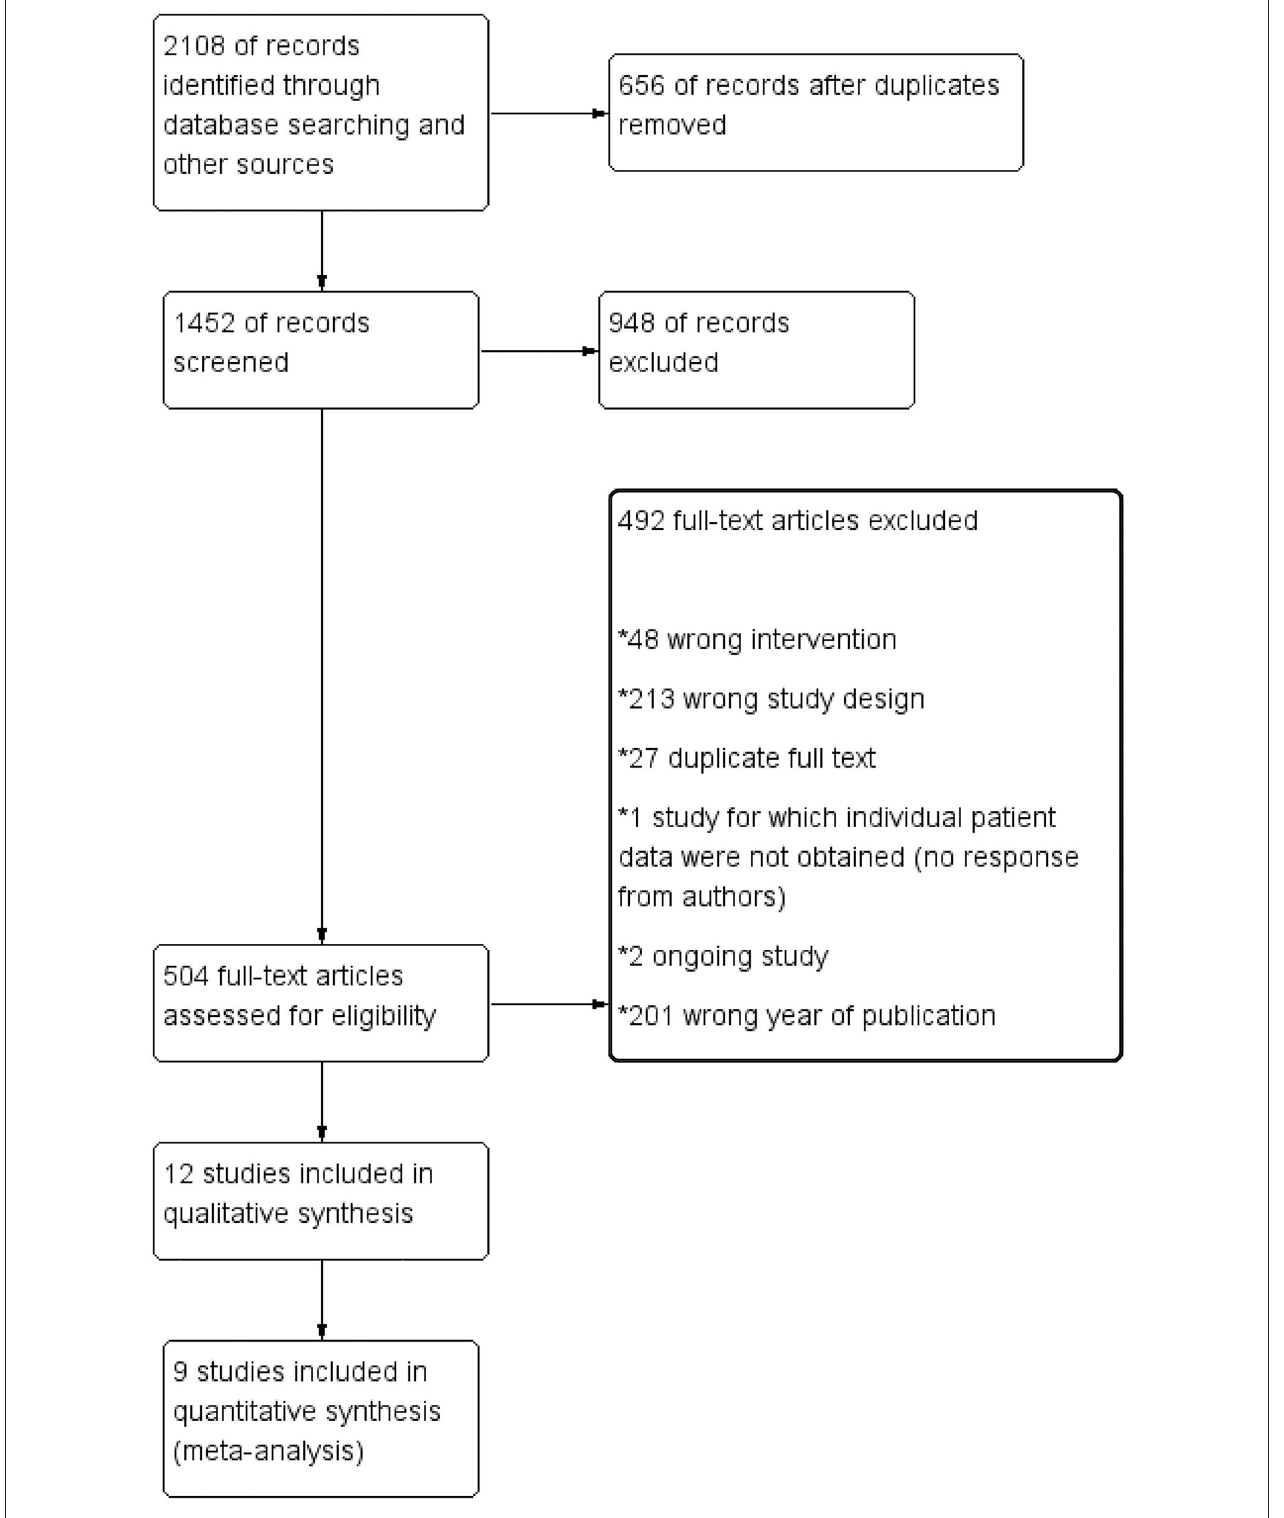
FIGURE 1 | The flow diagram of retrieved and included